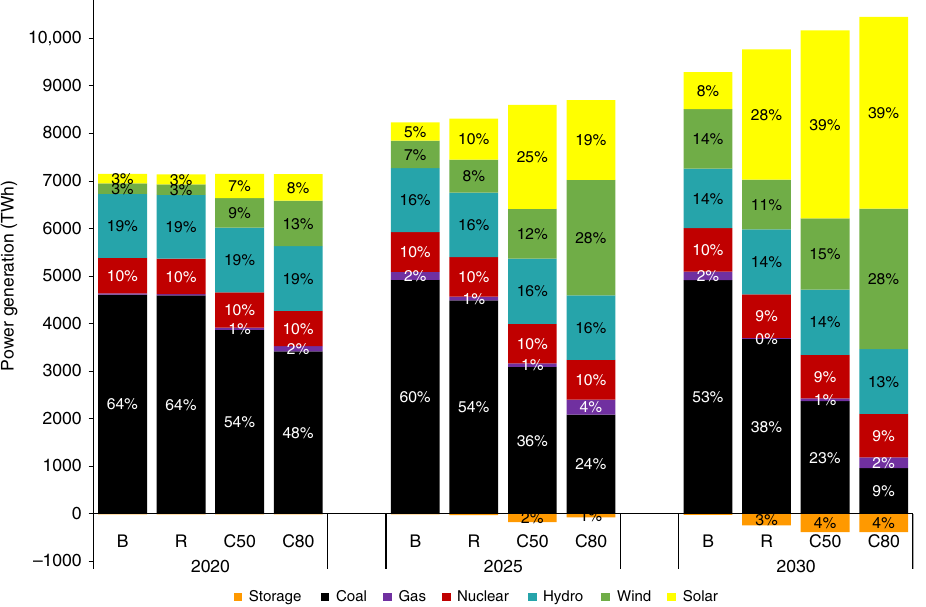
Fig. 2 National power-generating mix for four scenarios in 2020, 2025, and 2030. The scale of the bar chart are the generation by technologies, and the data labels show the share of generation by each technology in total generation. Source data are provided as a Source Data fi